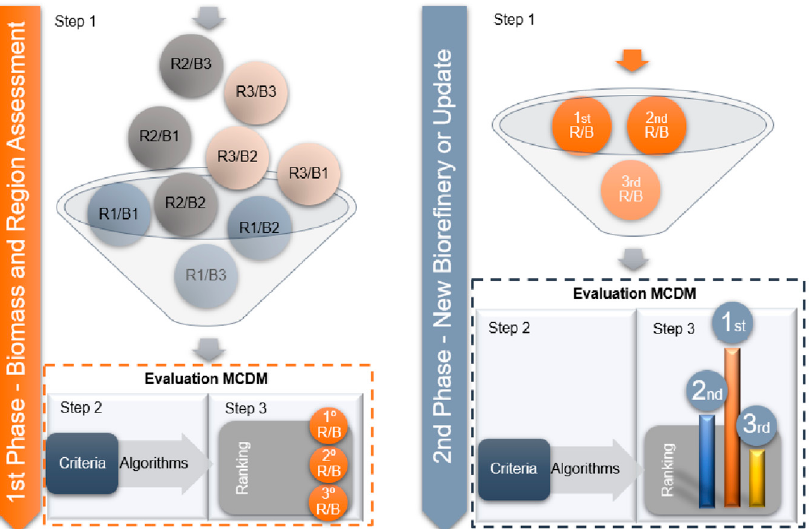
Figure 2. Framework for analyzing the role of algorithms in bioenergy projects. Note. R1/B1, R2/B1, R3/B1 refer to the ratio between region and type of biomass analyzed.